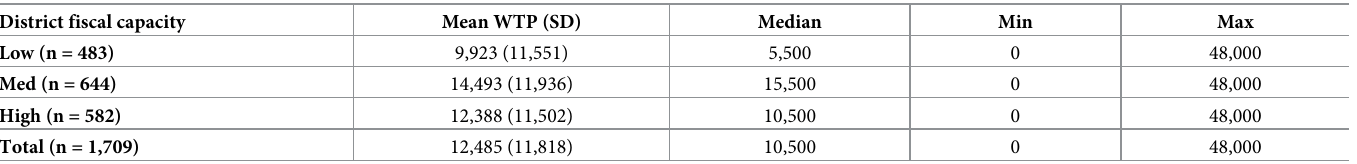
Table 5. Willingness to pay per capita across district fiscal capacity.